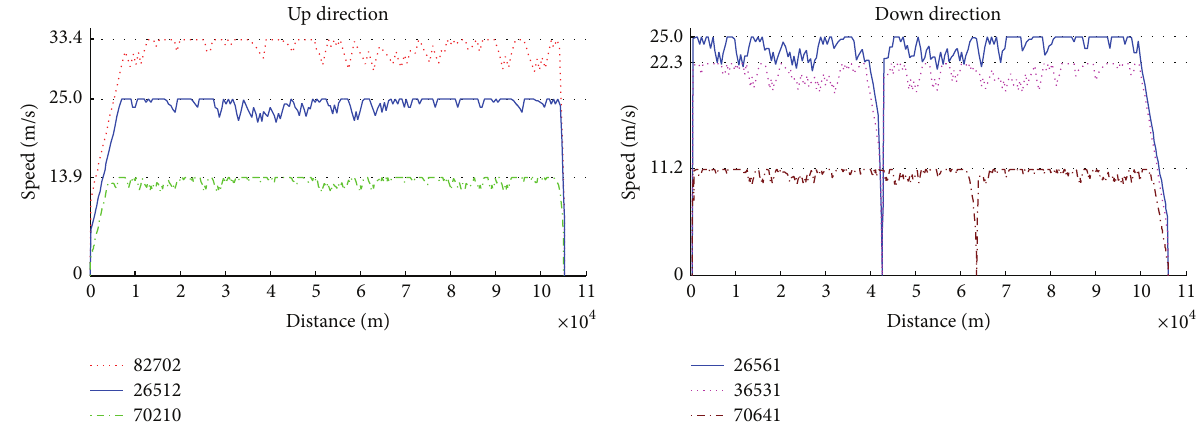
Figure 13: Train speed-distance curve (NCBS number: